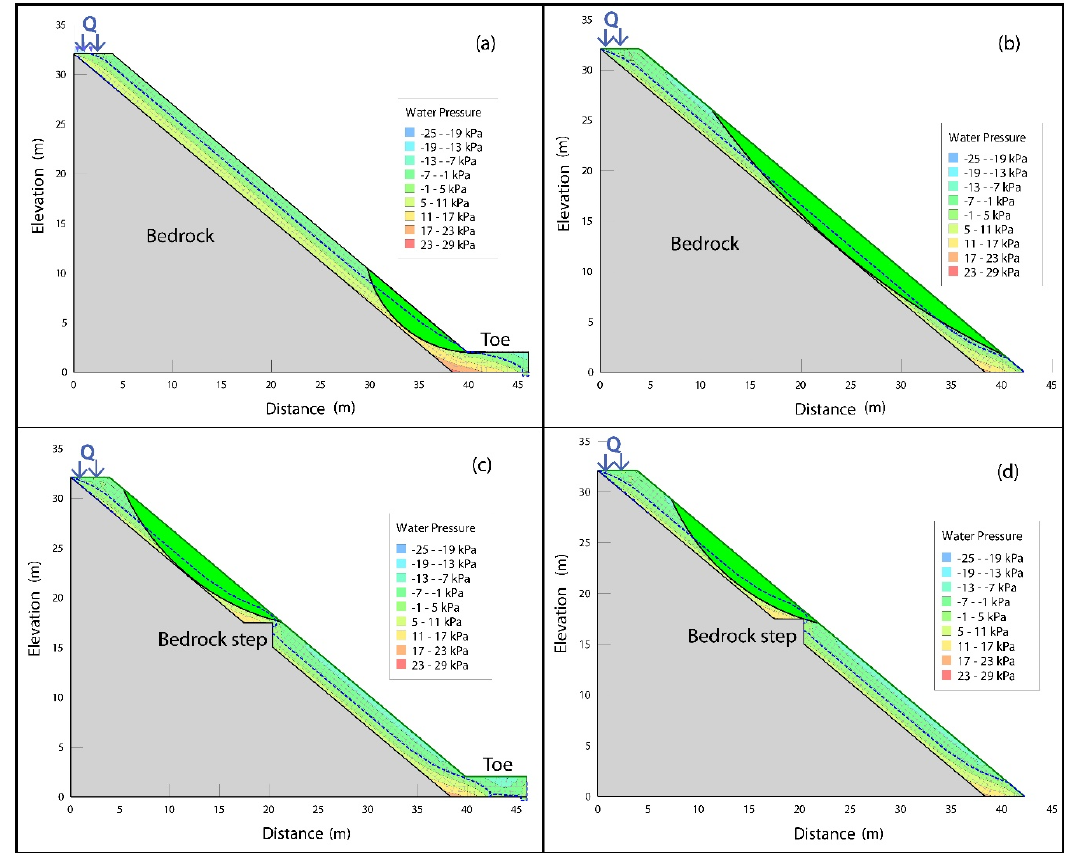
Figure 17. Preliminary numerical modelling of instabilities for four different slope bedrock geometries. Table 8. Water flow input to cause slope instability (F.S. = 1) in a numerical model (Geoslope).